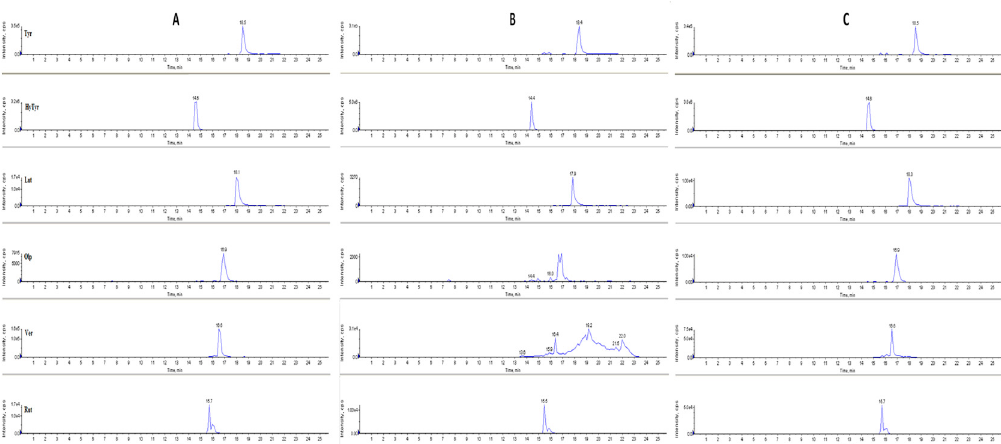
Figure 3. HPLC-MS chromatograms in multiple reactions monitoring MRM mode of bio-active compounds in the aqueous solutions of whole olive leaves after five days of maceration with: ultrapure water ( A ); microfiltered water ( B ) and osmosis-treated water ( C ).